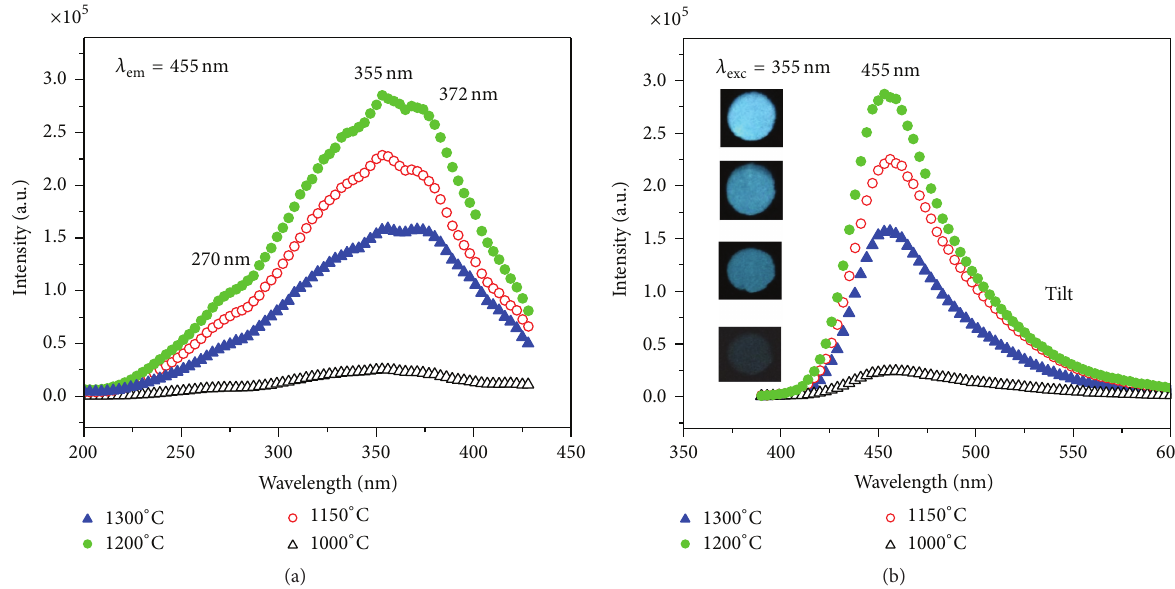
= 455 nm ) and (b) emission spectra (𝜆 em